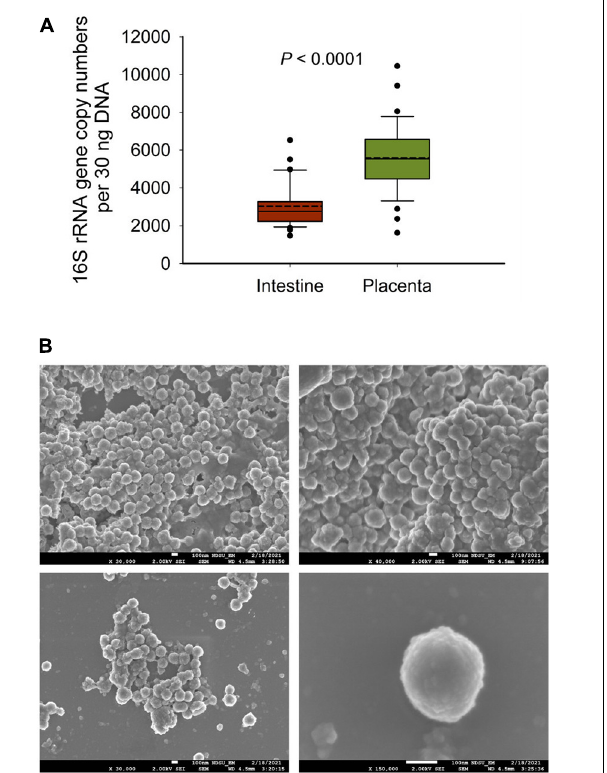
FIGURE 4 | (A) The total bacterial abundance in intestinal and placental tissue ( n = 33 each) samples estimated by qPCR and (B) scanning electron microscopy (SEM) images of microbial cells detected from fetal fluid samples of 83-day-old calf fetuses; white bars at the bottom of each image indicate 100